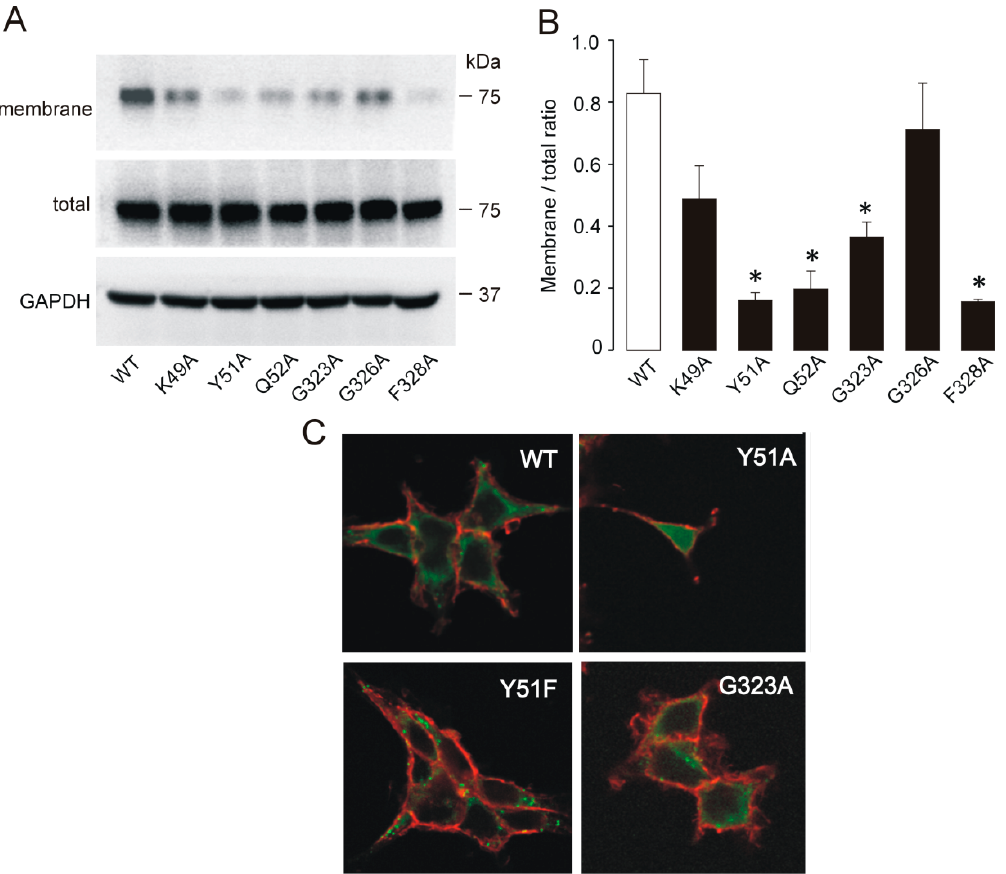
Figure 2. Membrane expression of the P2X7 WT and low-functioning extracellular vestibule mutants. ( A ) Western blots showing the expression pattern of the WT, K49A, Y51A, Q52A, G323A, G326A, and F328A receptors. The expression level of the receptors in the plasma membrane, the total expression level of the receptors, and the expression level of the housekeeping gene GAPDH were examined. ( B ) The relative surface protein expression of the WT and mutant receptors calculated as the ratio of signal intensity of P2X7 expressed at the membrane to the total P2X7 (membrane / total ratio) using GAPDH as a loading control for both the membrane and the total protein expression. The expression level was examined in 3–9 experiments, and the data are expressed as the means ± SEMs; * p < 0.05 between WT and alanine mutants. ( C ) Confocal microscopy showing the presence of the WT-YFP, Y51A-YFP, Y51F-YFP, and G323A-YFP tagged receptors (green signal) on the cell surface (red signal; wheat germ agglutinin marked outer membrane) and in the cytosol of transfected HEK293T cells; objective 63x.